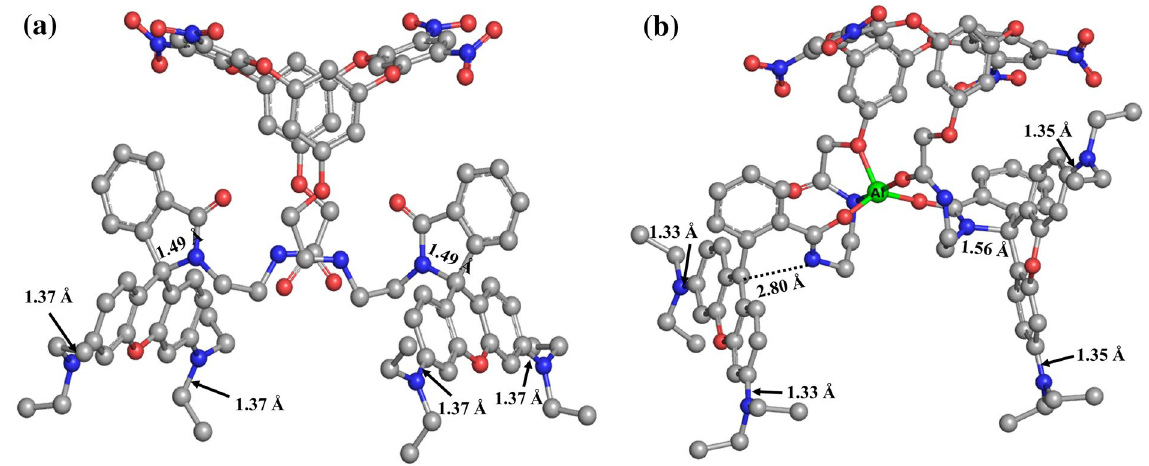
Figure 7. Ground state optimized geometries of ( a ) L and ( b ) L-Al 3+ complex (Hydrogens are eliminated for better